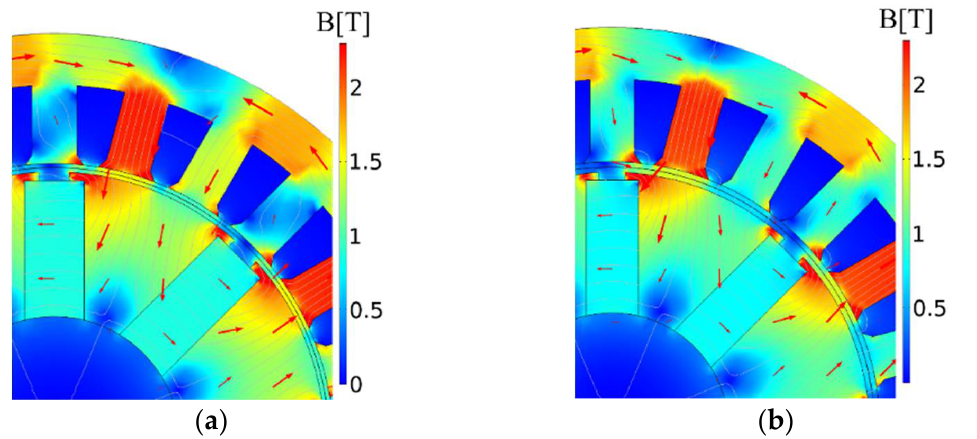
Figure 21. Magnetic flux distribution of geometries with changed rotor shape of ( a ) V20, new and ( b ) V30, new. Table 5. Average torque and torque